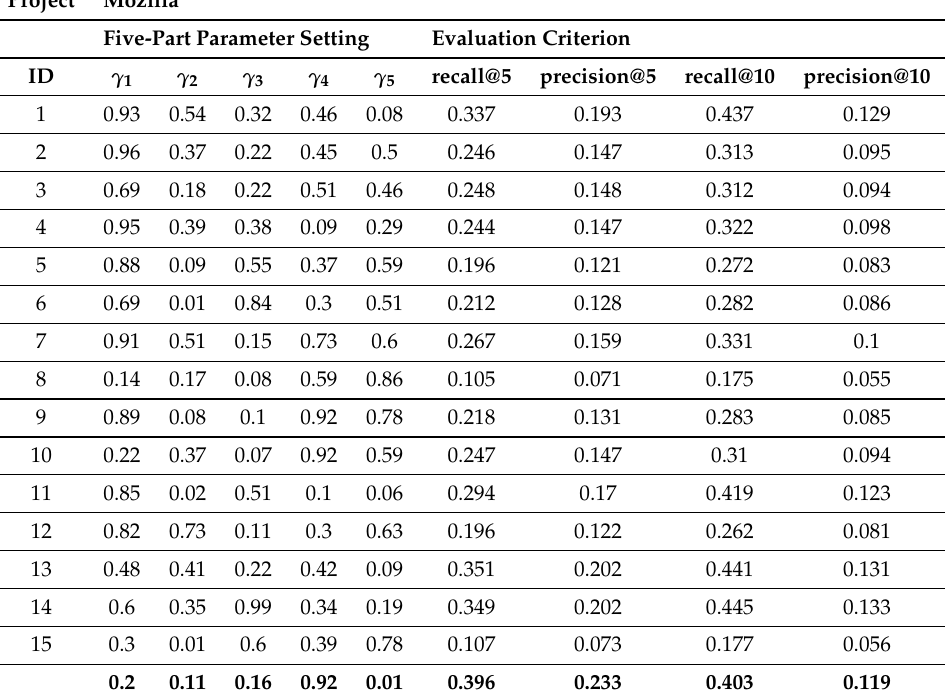
Table 7. Effects of different parameter settings on experimental results for the Mozilla dataset, and the last behavior in the table is the parameters measured by our proposed ABC-DR algorithm for the Mozilla dataset.